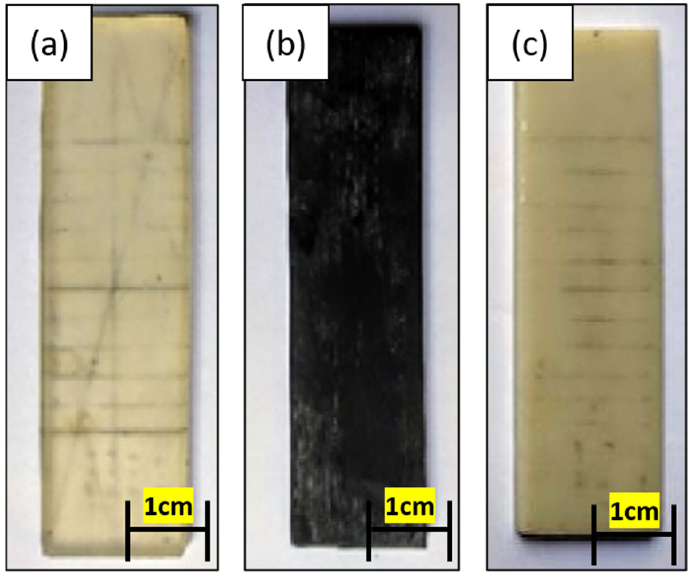
Figure 2. ( a ) Pure Epoxy sample ( b ) Epoxy/Graphene sample ( c ) Epoxy/ceramic